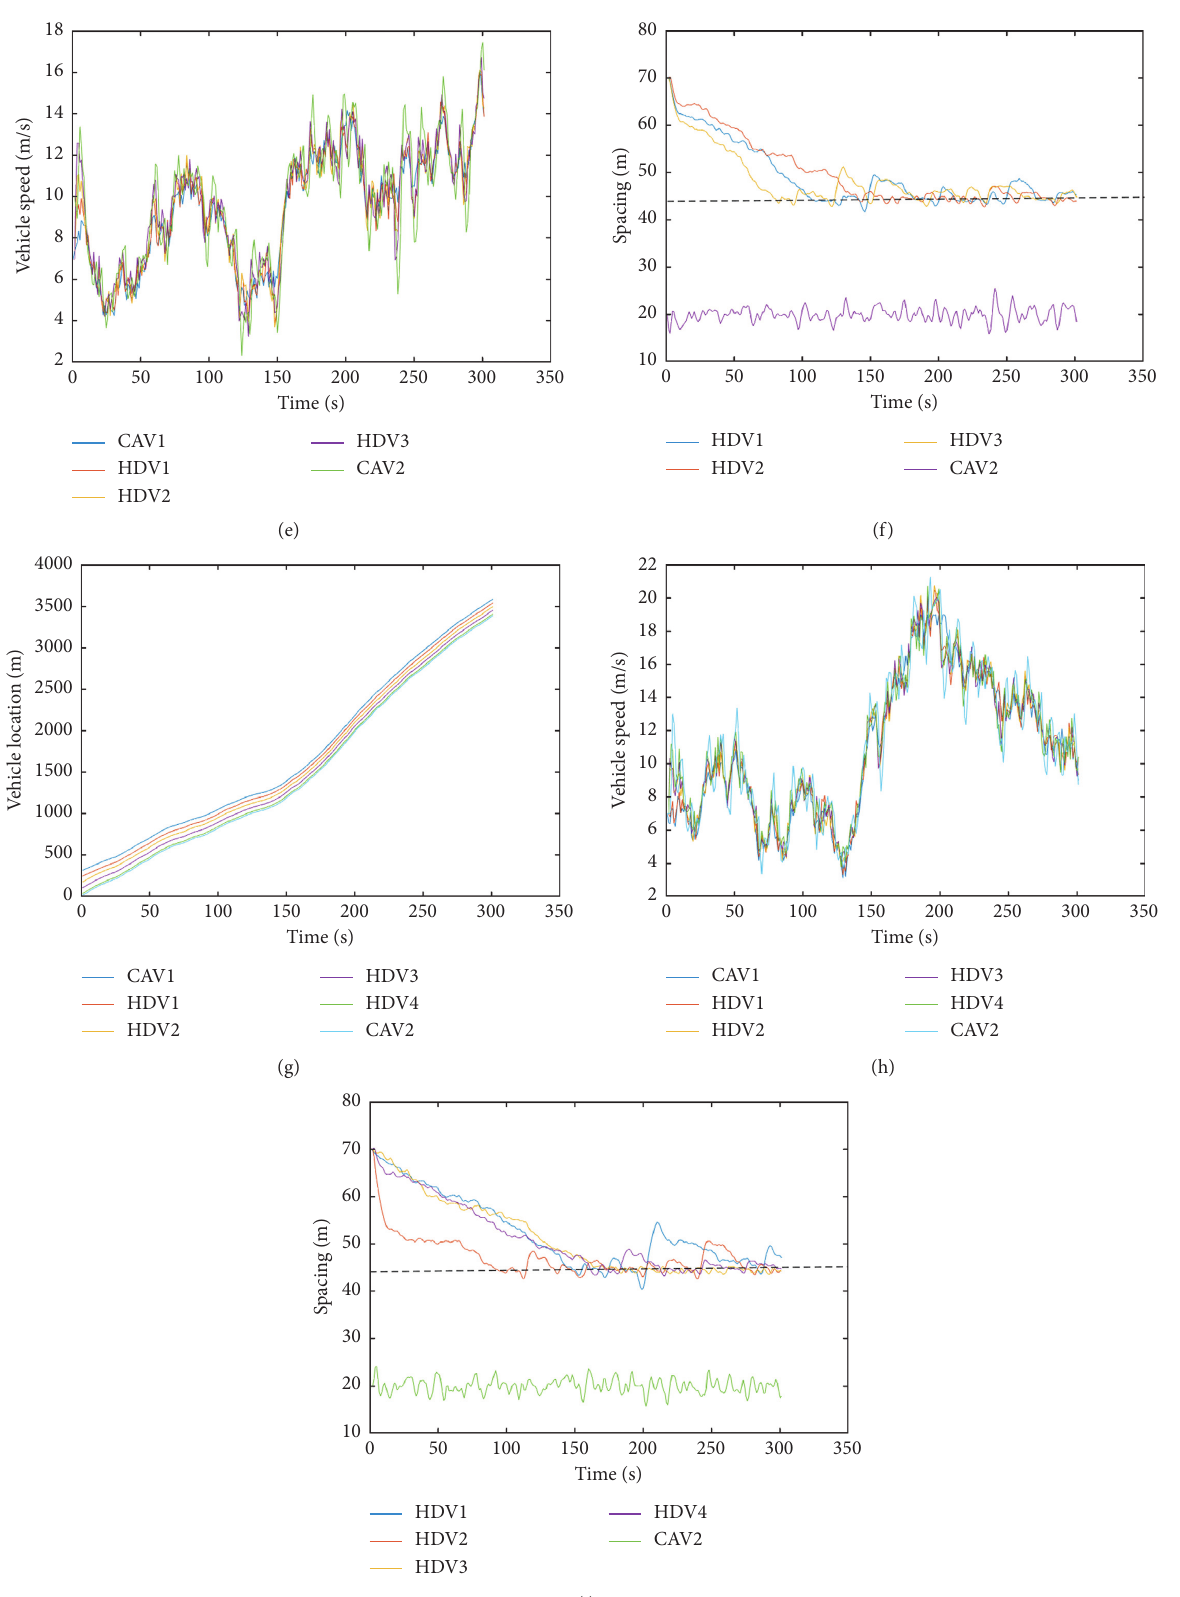
Figure 11: The driving situations of the fleet in change 1, change 2, and change 3. (a) The vehicle location of CAVs and HDVs (change 1). (b) The vehicle speed of CAVs and HDVs (change 1). (c) The spacing of formation (change 1). (d) The vehicle location of CAVs and HDVs (change 2). (e) The vehicle speed of CAVs and HDVs (change 2). (f) The spacing of formation (change 2). (g) The vehicle location of CAVs and HDVs (change 3). (h) The vehicle speed of CAVs and HDVs (change 3). (i) The spacing of formation (change